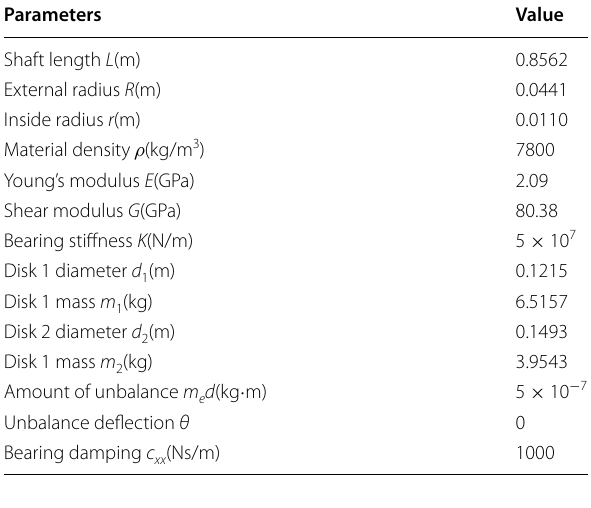
Table 1 The physical parameters of the rotor system